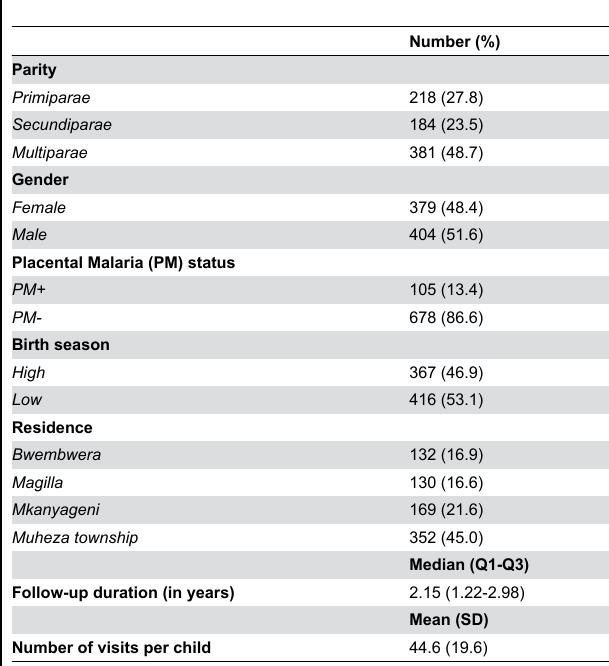
Table 1. Demographic characteristics of the